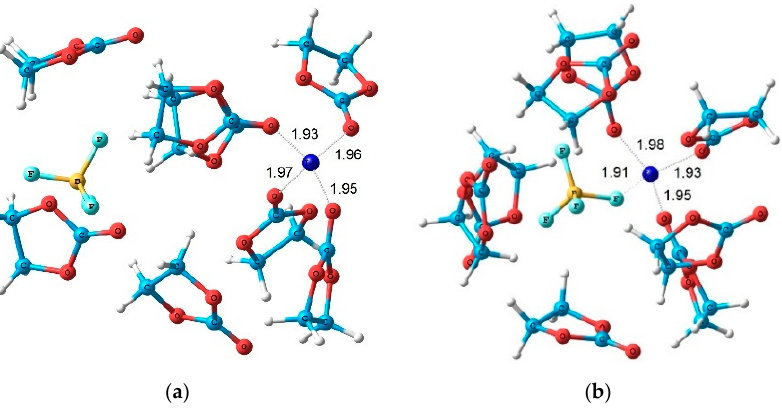
Figure 7. Theoretical structures of ( a ) Li + –4ECs and BF 4 –4ECs solvate-separated ion pair and ( b ) LiBF 4 –8ECs contact ion pair. EC: ethylene carbonate. Interatomic distances are given in angstrom [121].